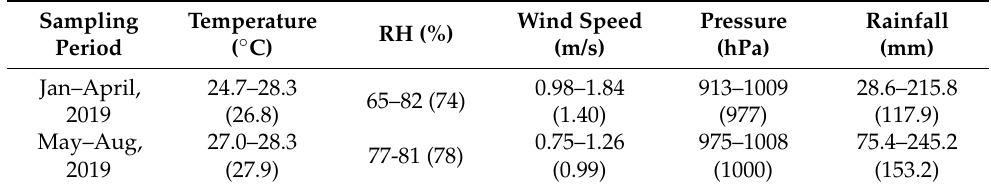
Figure 1. Location of sampling site, in Hat Yai, Songkhla, southern Thailand; Prince of Songkla University (PSU). Table 1. Meteorological parameters during different sampling